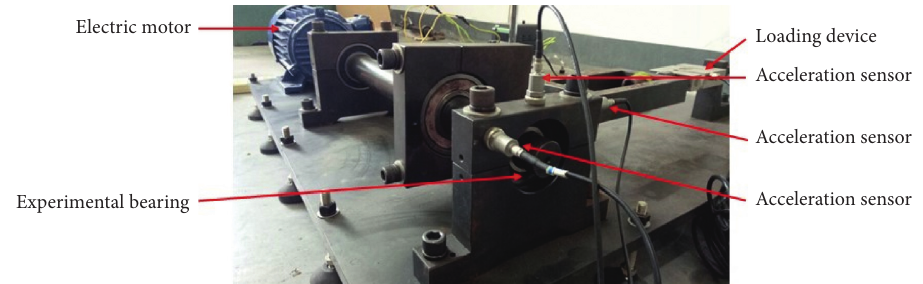
Figure 3: The flowchart of the proposed